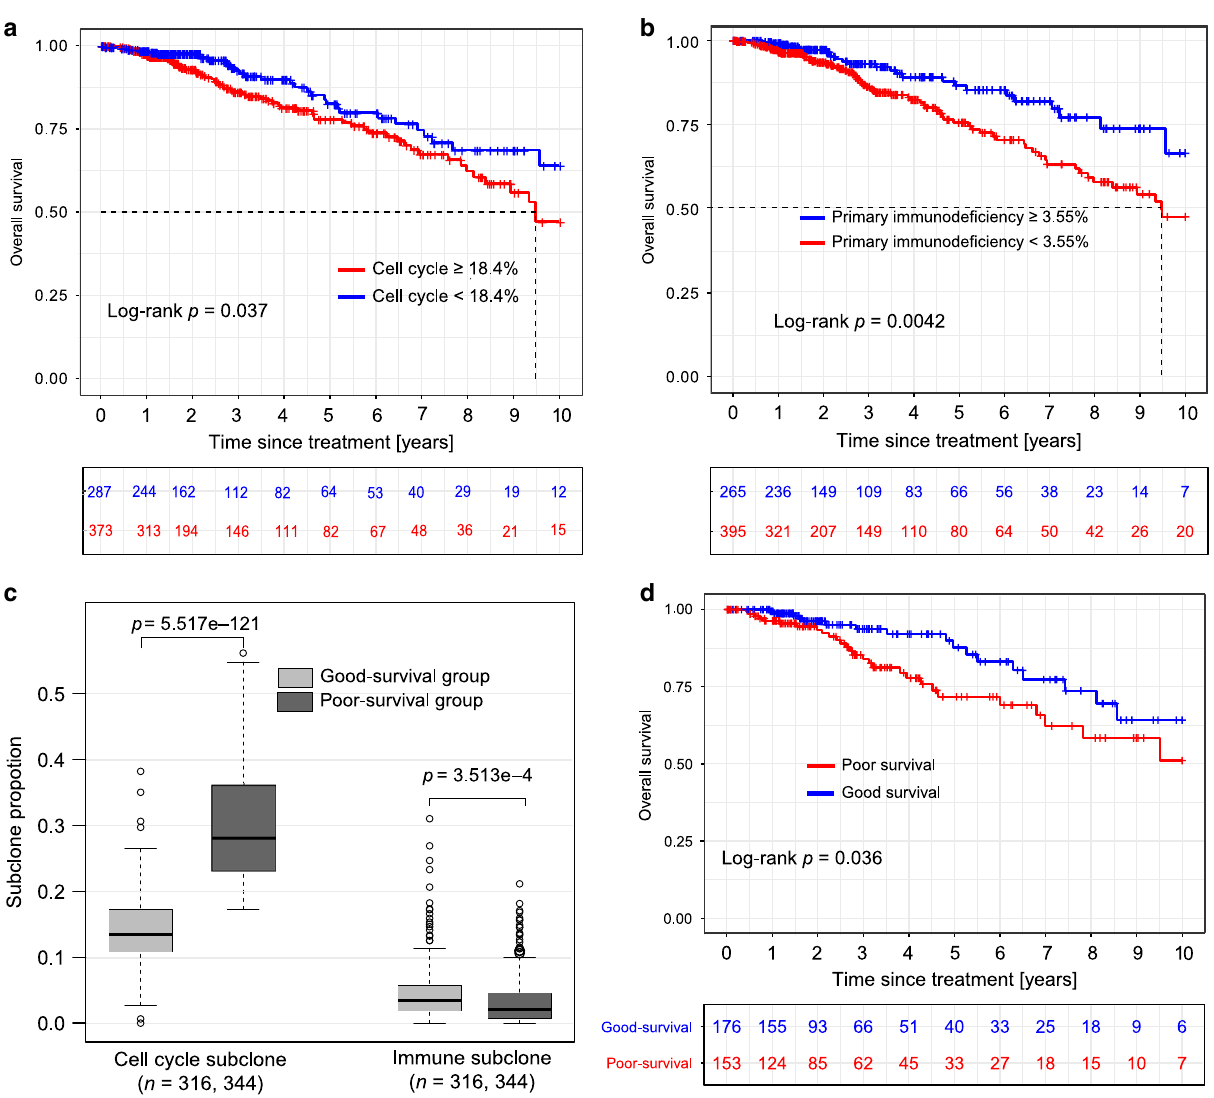
Fig. 4 Genomic subclones correlate signi fi cantly with patient survival. Kaplan – Meier curves of OS for the cell cycle ( p = 0.037, two-sided log-rank test) ( a ) and primary immunode fi ciency ( p = 0.0042, two-sided log-rank test) ( b ) genomic subclones. c Proportional compositions of key predictive subclones of the cell cycle and primary immunode fi ciency. Cell cycle subclone: t = − 29.223, p = 5.517e-121, two-tailed Student ’ s t test. Immune-subclone: t = 3.593, p = 3.513e-4, two-tailed Student ’ s t test. Patients were grouped into good-survival ( n = 316) and poor-survival ( n = 344) according to the estimated fractions of the two subclones. d Kaplan – Meier curves of overall survival between good survival ( n = 153) and poor survival ( n = 176) groups in the genomic testing dataset ( p = 0.036, two-sided log-rank test). Red and blue plots represent poor survival and good survival groups, respectively. In the boxplot, centre line represents median; box limits indicate upper and lower quartiles; whiskers represent 1.5 × interquartile range and points are outliers. Source data are provided as a Source data fi